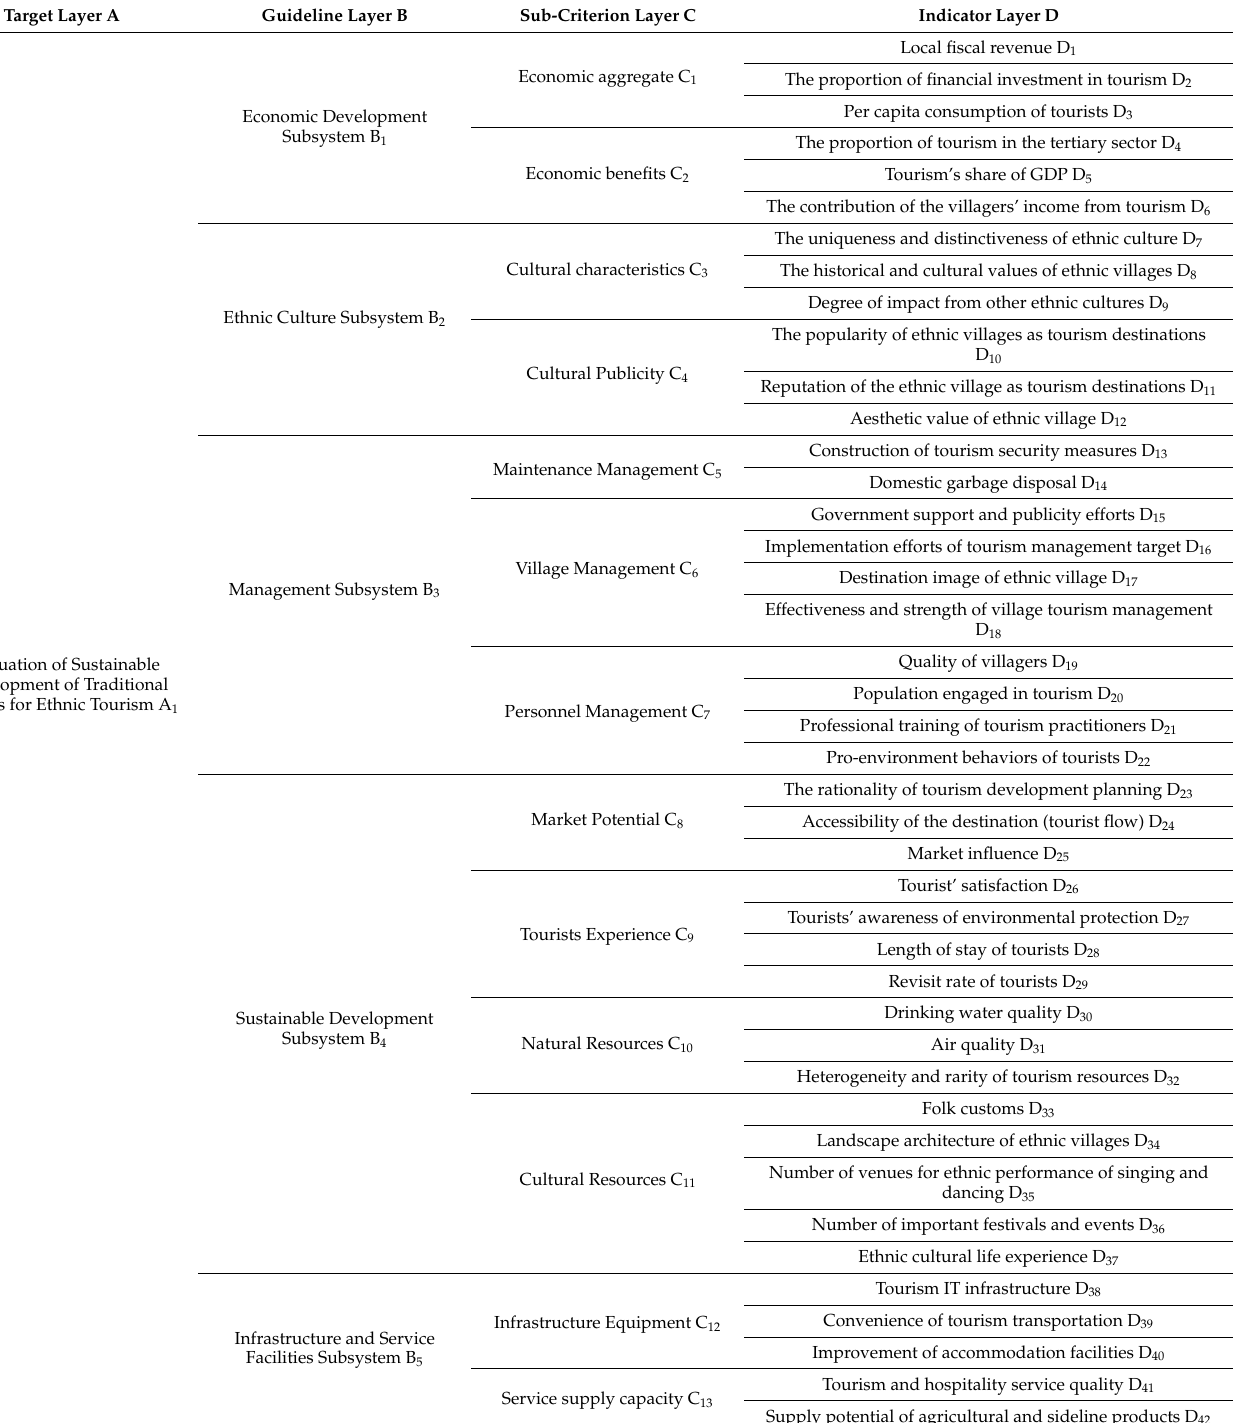
Table 1. Evaluation System of Sustainable Development of Traditional Ethnic Village Tourist